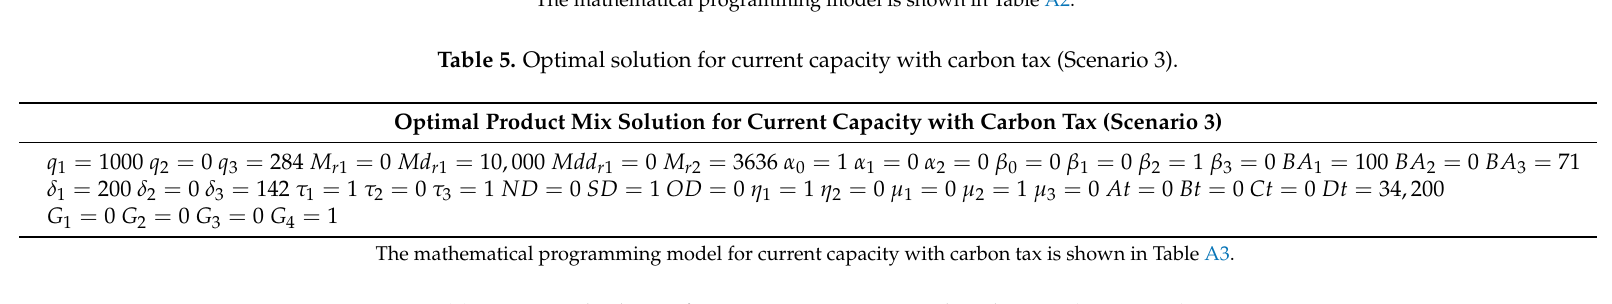
Table 6. Optimal solution for capacity expansion with carbon tax (Scenario